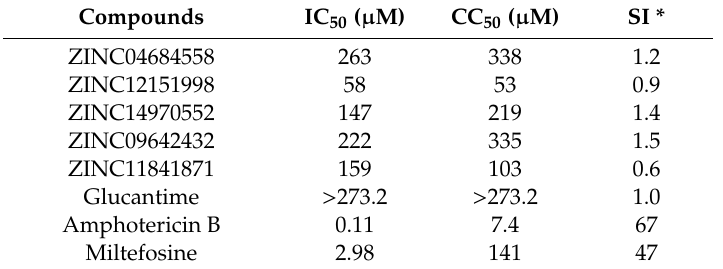
Table 5. Leishmanicidal activity, cytotoxicity, and selectivity index of compounds from ZINC